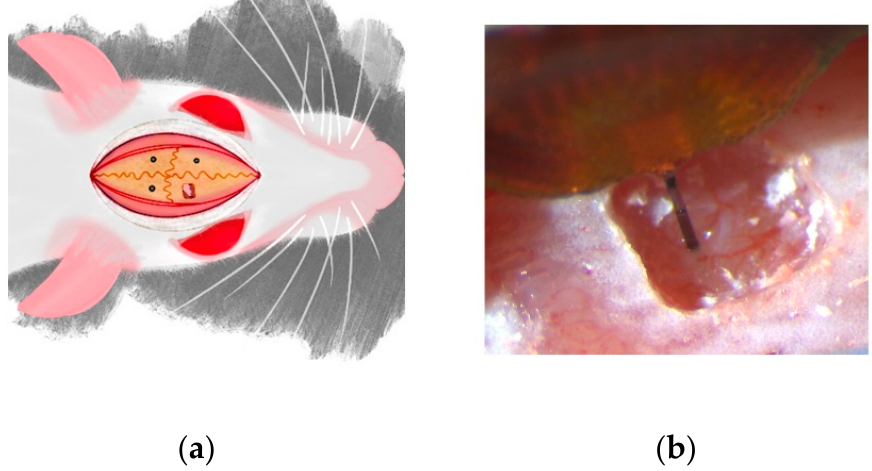
Figure 1. Surgical implantation of neural probes and neurophysiological data acquisition. ( a ) Black dots represent the site of bone screw placement, and the craniotomy was performed in the upper right quadrant defined by ~2 mm anterior to bregma and ~2 mm lateral central suture line; ( b ) implantation of the NeuroNexus probe (A1x16-3mm-100-177-CM16LP) in the rat cortical surface is shown here.